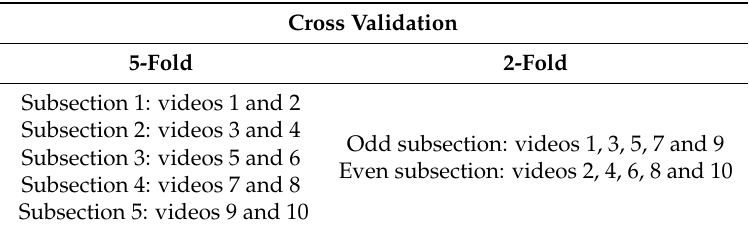
Table 2. Cross-validation arrangement over the